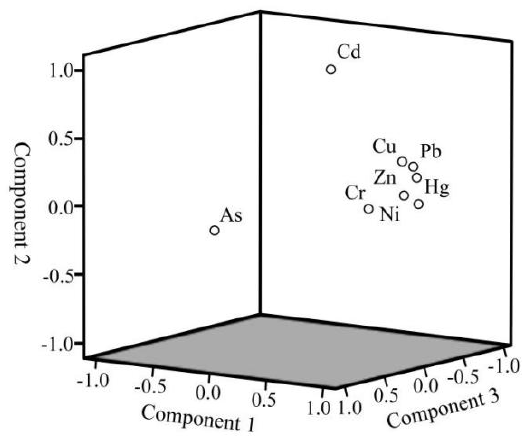
Figure 6. Plot of loading of three principal components in PCA results.